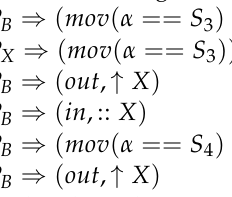
Figure 5. ( a ) State Chart for Agent “Bus” ( b ) State Chart for Agent “Passenger”. In the above two lines, the passengers that are inside the bus indicate that the bus is parent of the passengers, who should get off the bus, whereas the passenger standing on the station are siblings of the bus and should ride on the